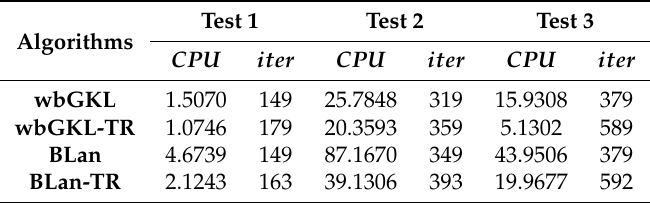
Table 6. Compute 5 smallest positive eigenvalues for Test